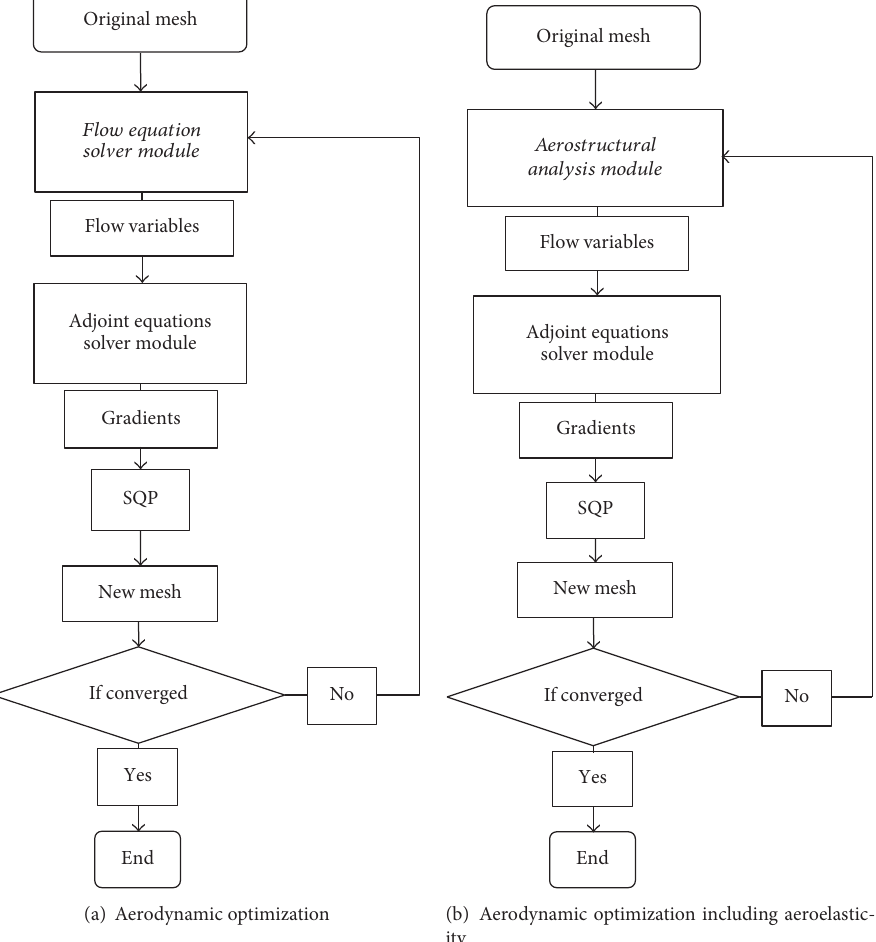
Figure 3: Optimization flow